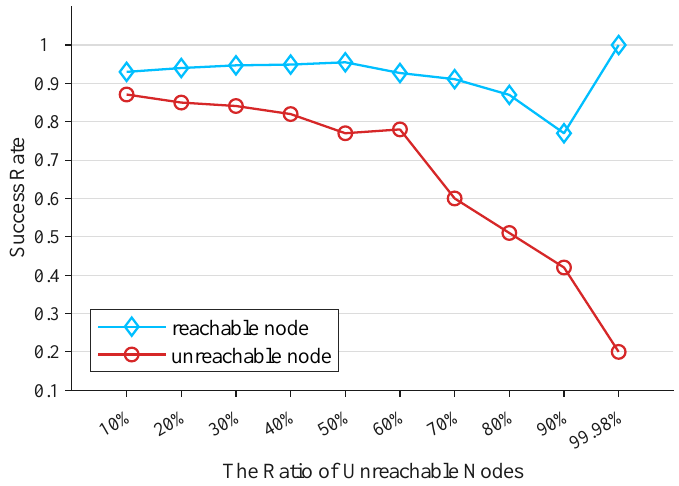
Figure 18. Lookup success rate of reachable and unreachable nodes with different ratio of unreach- able